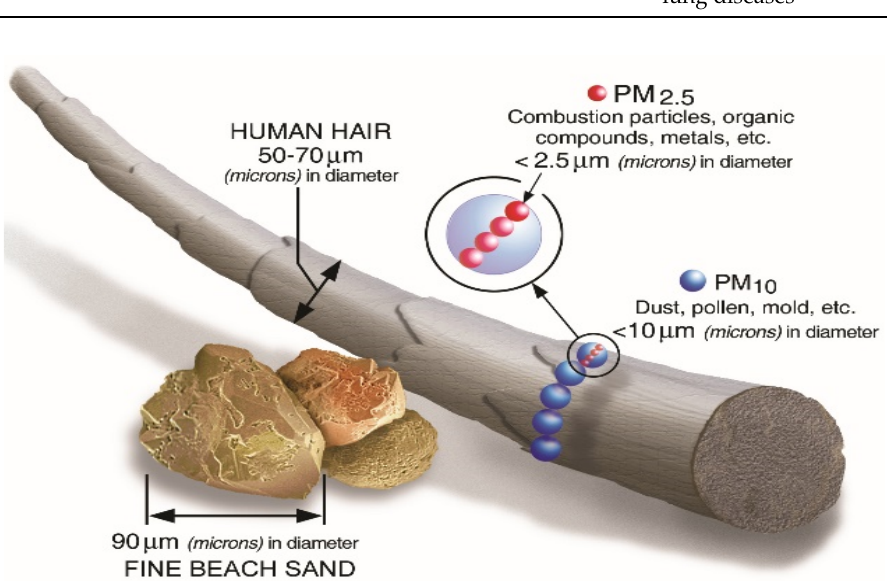
Figure 1. Size comparisons for PM particles. Source: retrieved from The United States Environmental Protection Agency (EPA) official website.